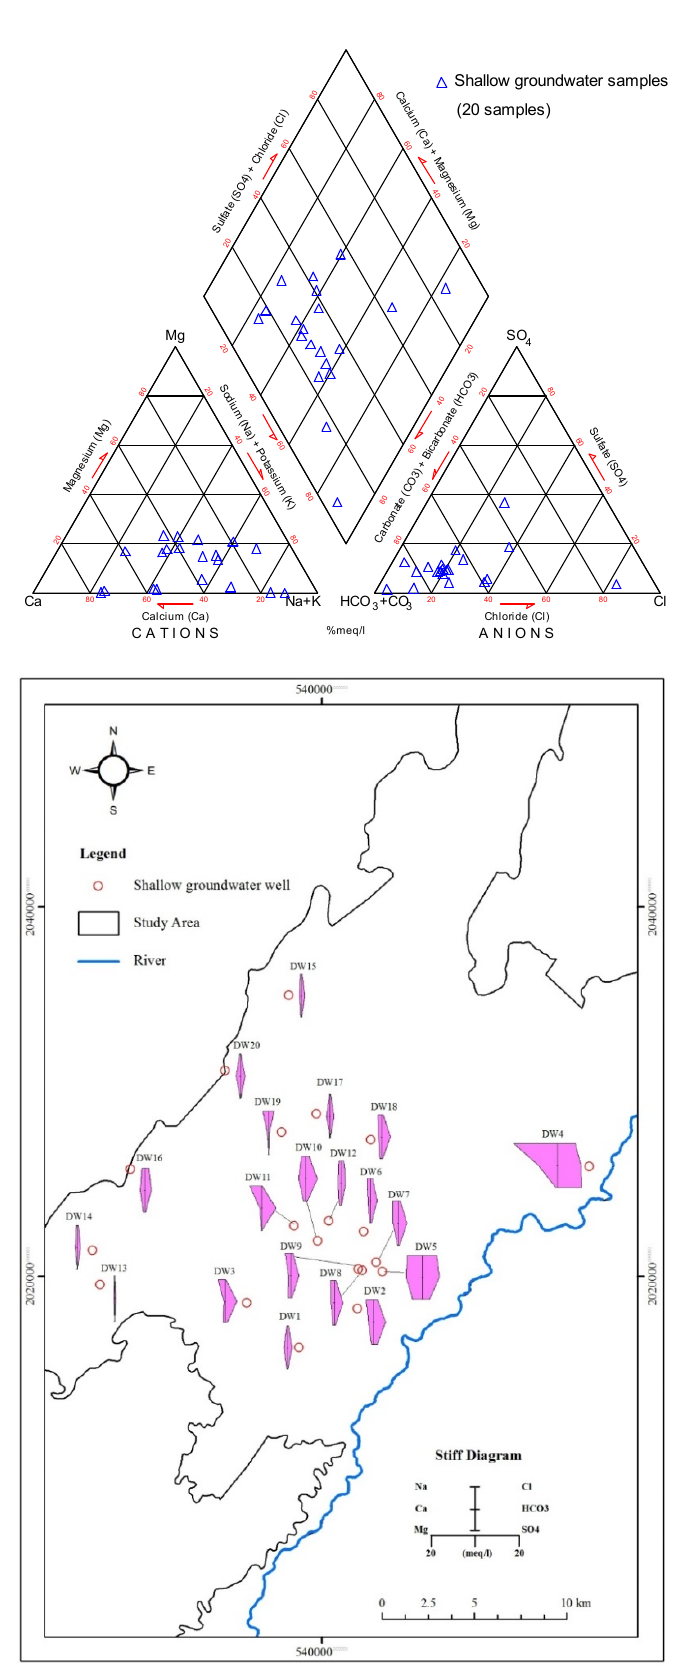
Figure 6. Piper and stiff diagrams for shallow groundwater samples.